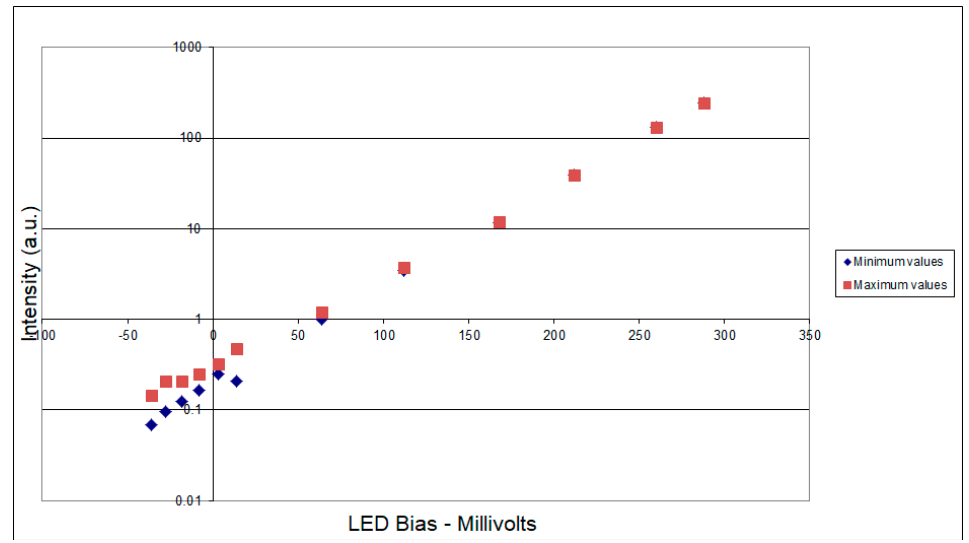
Figure 4. 201 °C LED Intensity vs. Bias Measured at 1450 nm. This semi-log plot shows points falling on a straight line (not shown) that crosses zero bias with non-zero intensity.